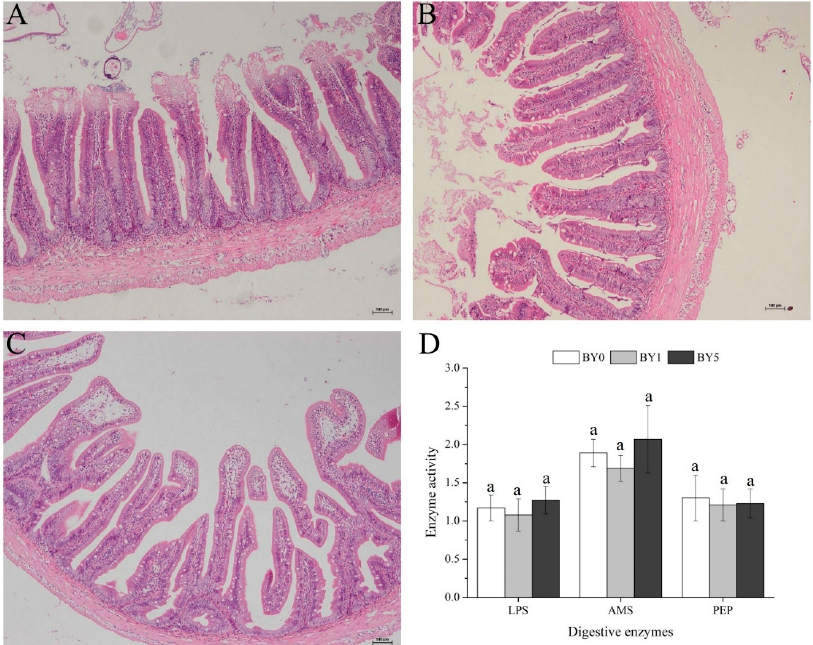
Figure 5. Midgut morphology of T. ovatus fed with BY0 ( A ), BY1 ( B ) and BY5 ( C ) diets, and digestive enzymes activities in the midgut of fish fed experimental diets ( D ). Values are presented as mean ± SE ( n = 18). The same letters indicate no significant differences ( p > 0.05). LPS, lipase (U g protein − 1 ); AMS, amylase (U mg protein − 1 ); PEP, pepsin (U mg protein − 1 ). Scale bar: 100 µ